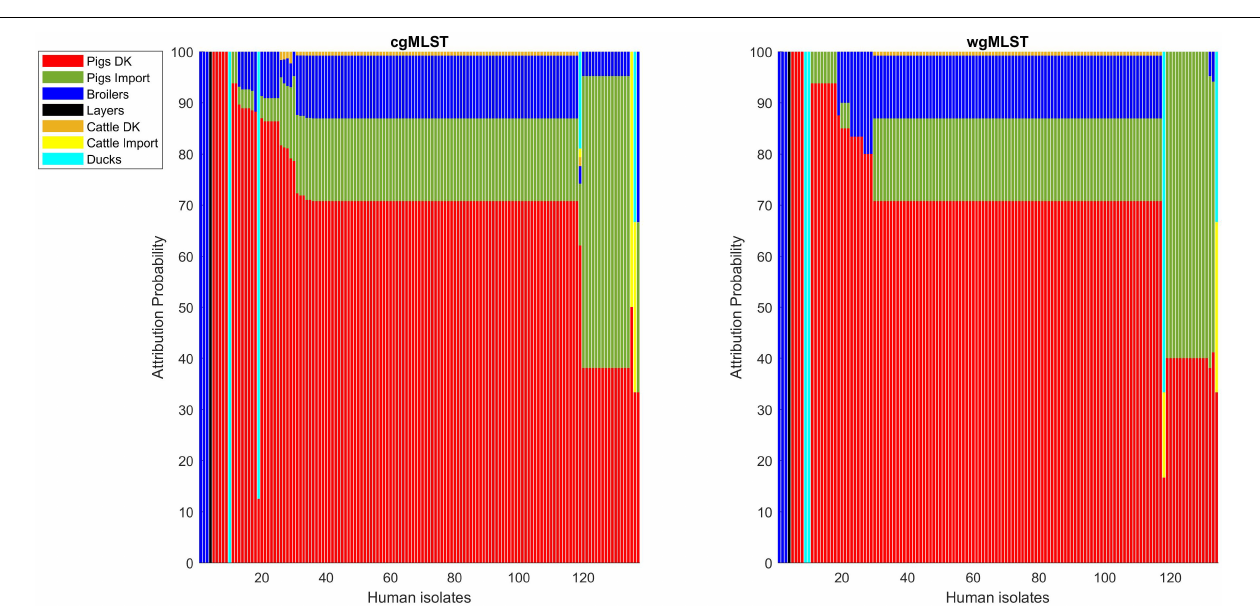
FIGURE 7 | Human isolate probability to originate from each source on the cgMLST pairwise distance matrix (left) and on the wgMLST pairwise distance matrix (right)